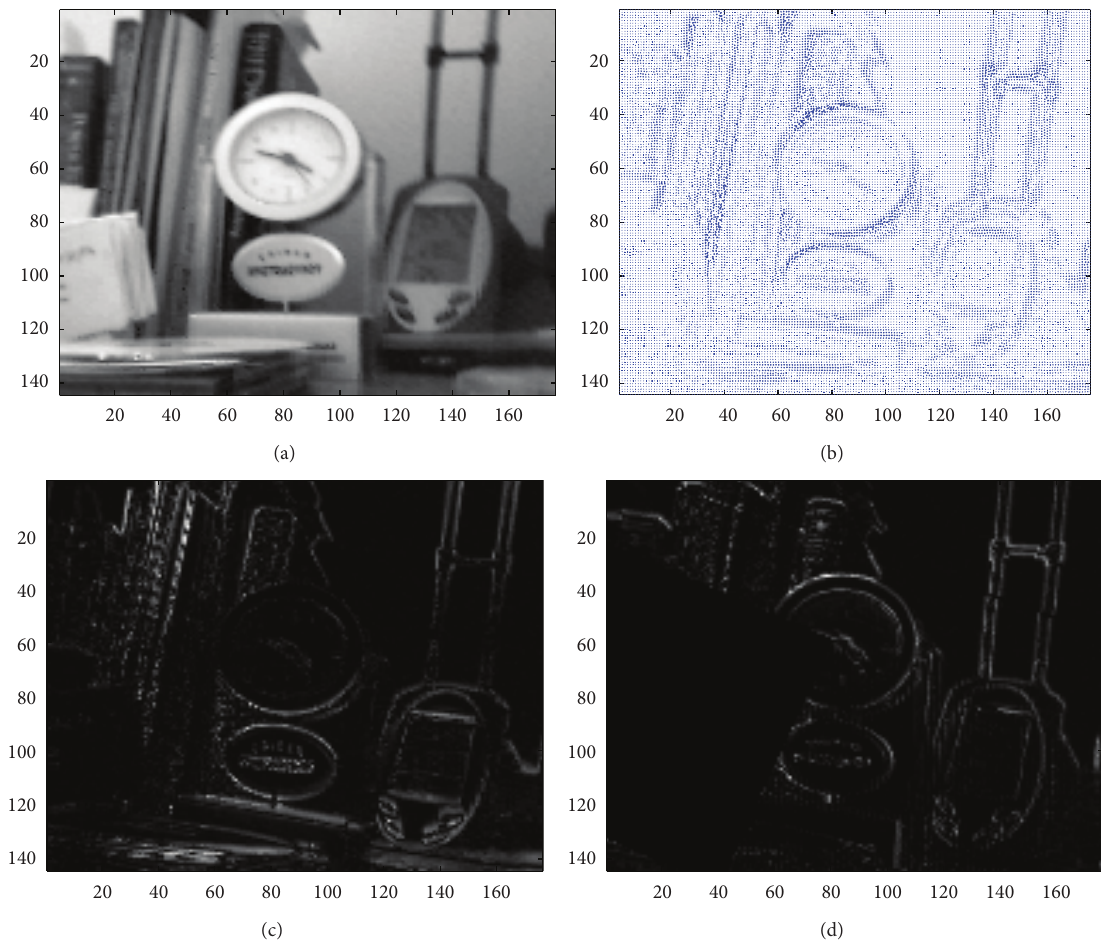
Figure 3: Example of stabilization results from the stabilization scheme proposed: (a) original frame No. 14 of the video sequence “My Office”; (b) dense optical flow field-estimated motion vectors between frames 14 and 15; (c) difference between original frames 14 and 15; (d) difference between stabilized frames 14 and